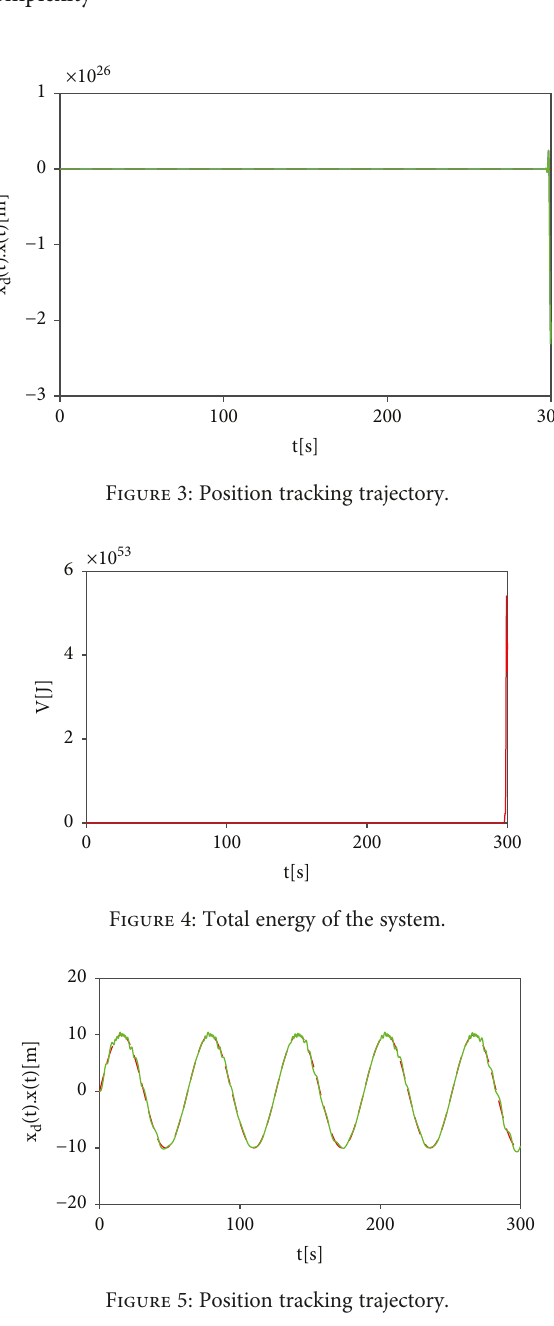
Figure 5: Position tracking trajectory.